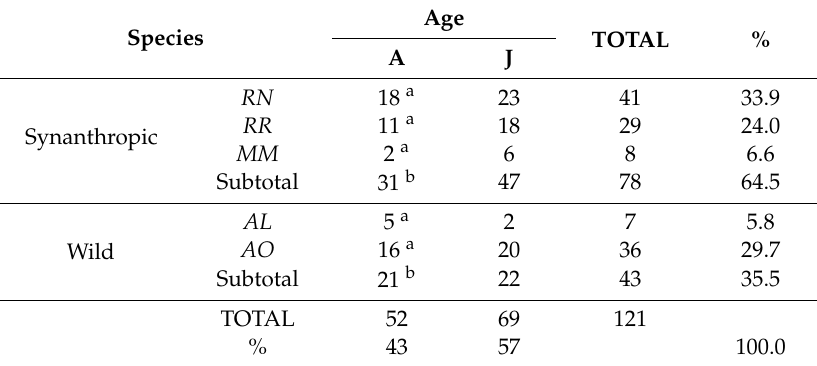
Table 1. Description of the characteristics of the di ff erent rodents trapped in dairy farms in the Los R í os Region,